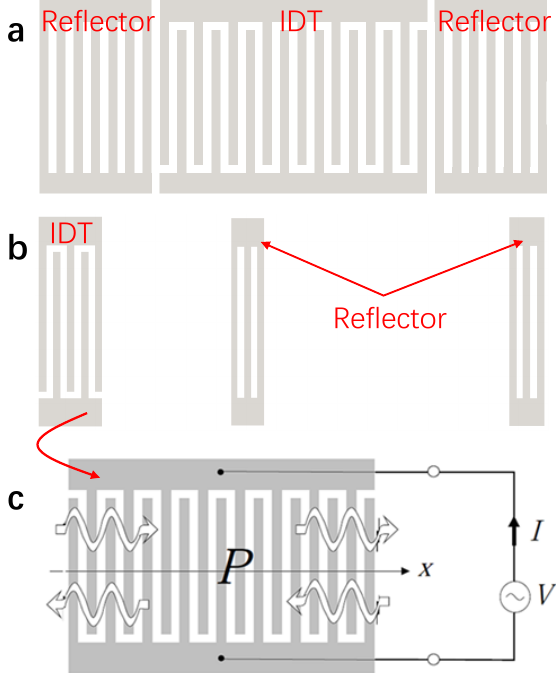
Figure 1. ( a ) One-port resonator pattern, ( b ) Reflective delay line pattern, ( c ) COM model for